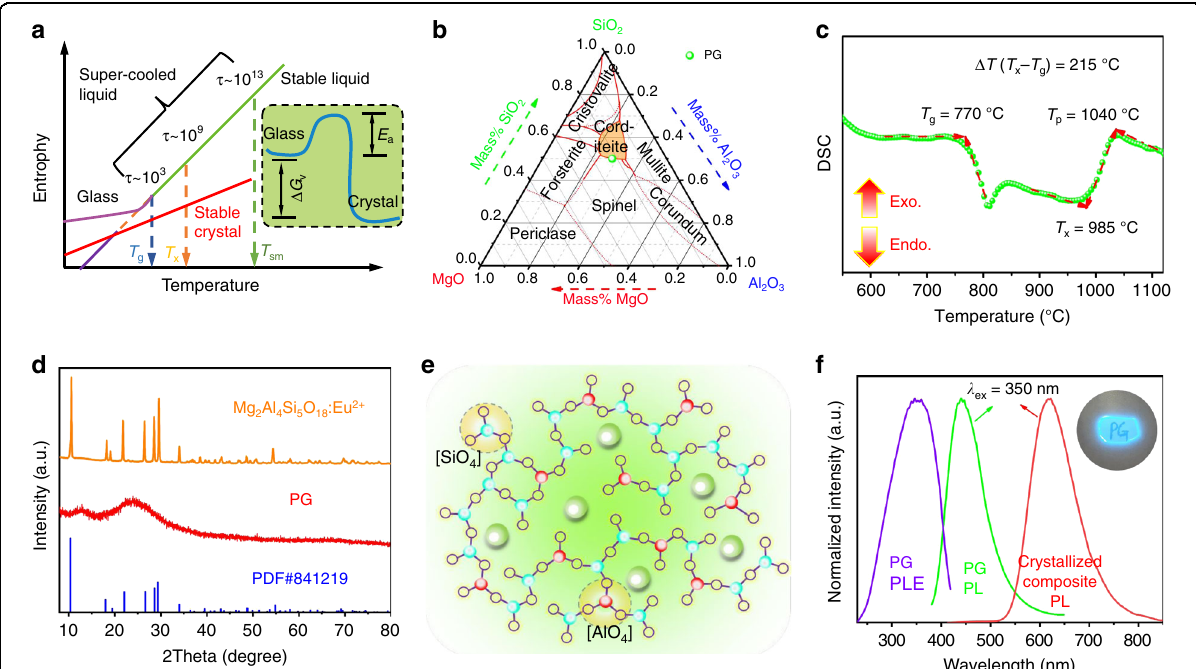
Fig. 1 Design and fabrication of Mg 2 Al 4 Si 5 O 18 :Eu 2 + composite phosphor. a Schematic illustration for the entropy of glass, stable crystal, super- cooled liquid, and stable liquid as a function of temperature. T g , T x , and T sm are the glass transition temperature, crystallization onset temperature, and the melting temperature of stable crystal, respectively. The inset illustrates free energy evolution of the system as glass crystallization proceeds. Δ G v means Gibbs free energy difference between metastable glass and stable crystal, and E a represents activated energy that needs to be overcome upon glass crystallization. b MgO – Al 2 O 3 – SiO 2 phase diagram, showing the PG composition in wt%. c DSC curve of PG recorded at a heating rate of 10 K/min. d XRD patterns of PG and the crystallized composite. e Schematic illustration of the two-dimensional structure of amorphous aluminosilicate glass network. f PL spectra of PG and the crystallized Mg 2 Al 4 Si 5 O 18 :Eu 2 + composite under 350 nm UV excitation, and PLE of PG measured by monitoring 450 nm emission, the inset photograph shows the PG taken under UV light